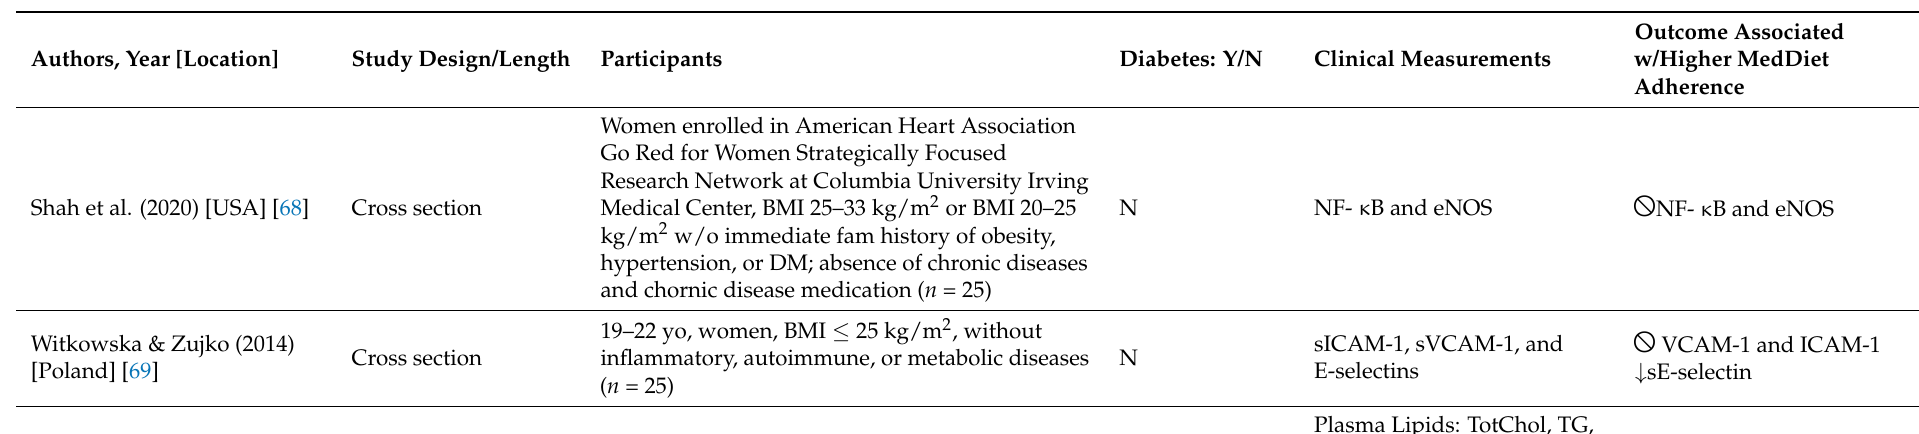
Table 2. Clinical Studies.